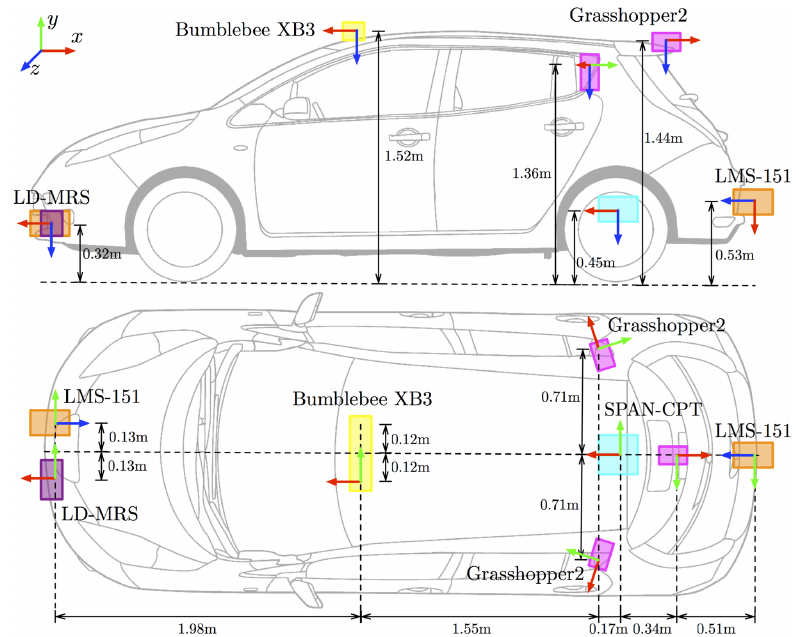
Figure 6. The RobotCar platform and sensor positioning setup.The global coordinates and sensor body coordinates are defined.All sensor extrinsics are provided as se(3) format in their software development kit (SDK) tools [43].